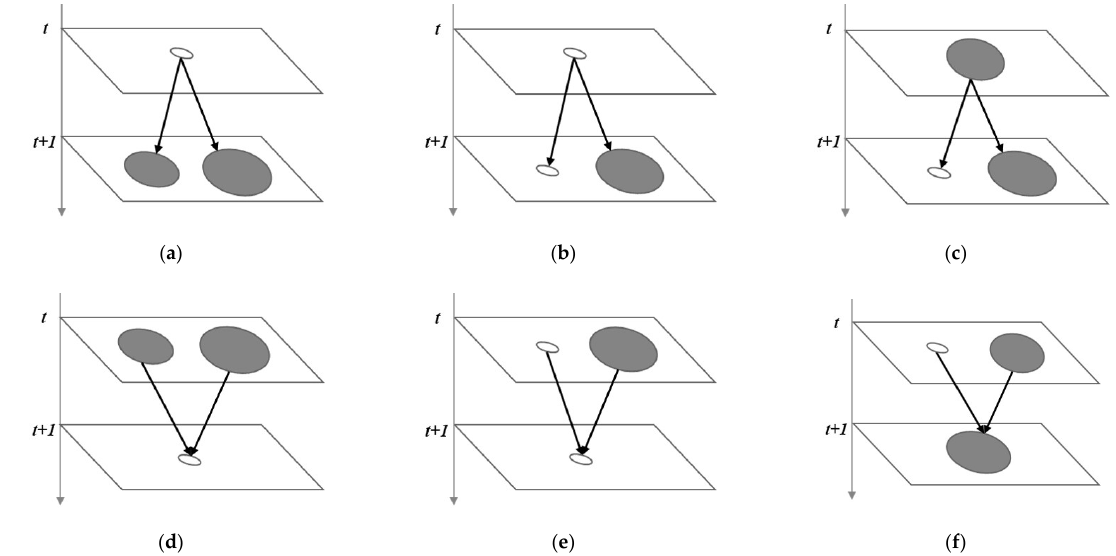
Figure 3. A diagram of false evolution relationships. ( a – c ) are false splitting relationships, and ( d – f ) are false merging